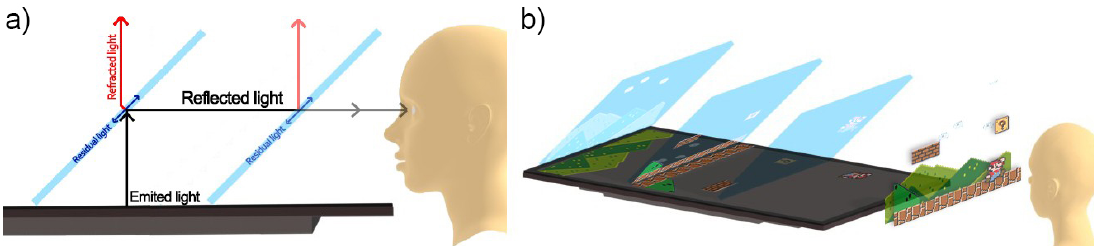
Figure 1. ( a ) Ray diagram on SliceView: the image emitted from a part of the monitor is reflected on the slice above it, then it refracts on the slices in front of it until it reaches the user. Primary refractions, secondary reflections and residuals are lost and reduce the final intensity. ( b ) Schematic diagram of a SliceView rendering a layered videogame (SNES Super Mario World TM